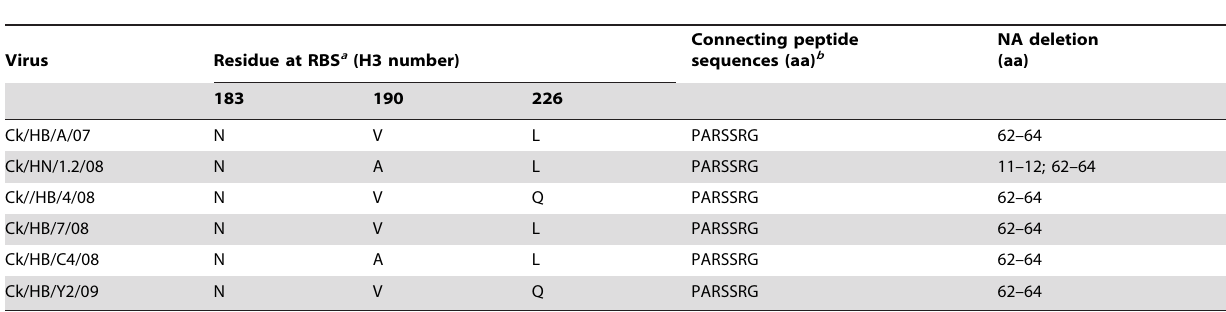
Table 4. Comparison of amino acid sequences of HA and NA of H9N2 viruses tested in this study